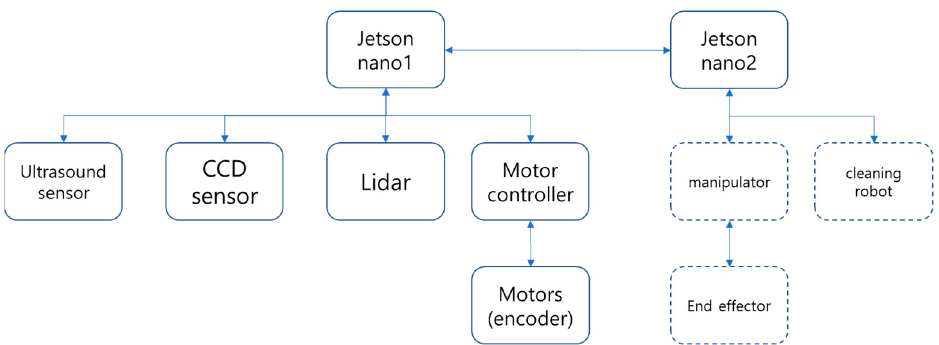
Figure 5. System structure.